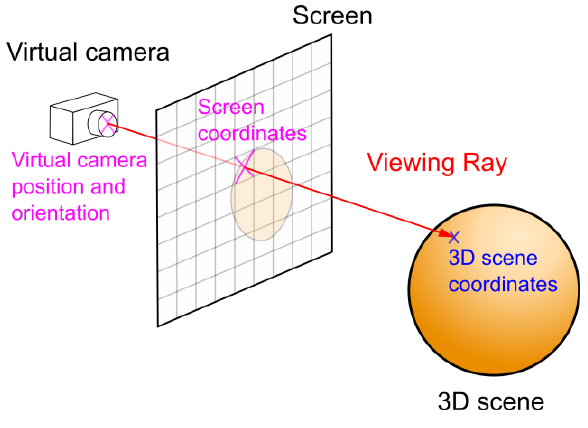
Fig. 3. Principle of ray casting method for 3D scene coordinates